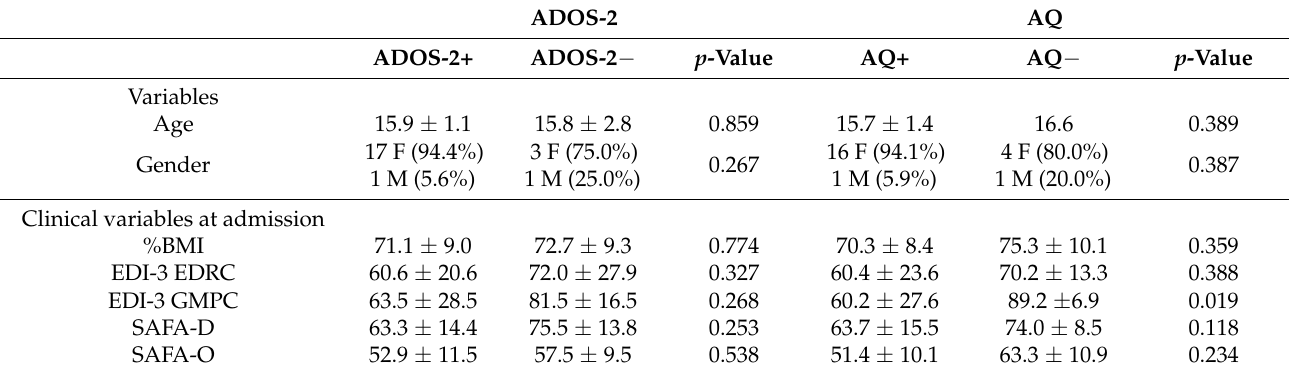
Table 2. Comparisons of clinical variables at admission between ASD+ and ASD − patients with